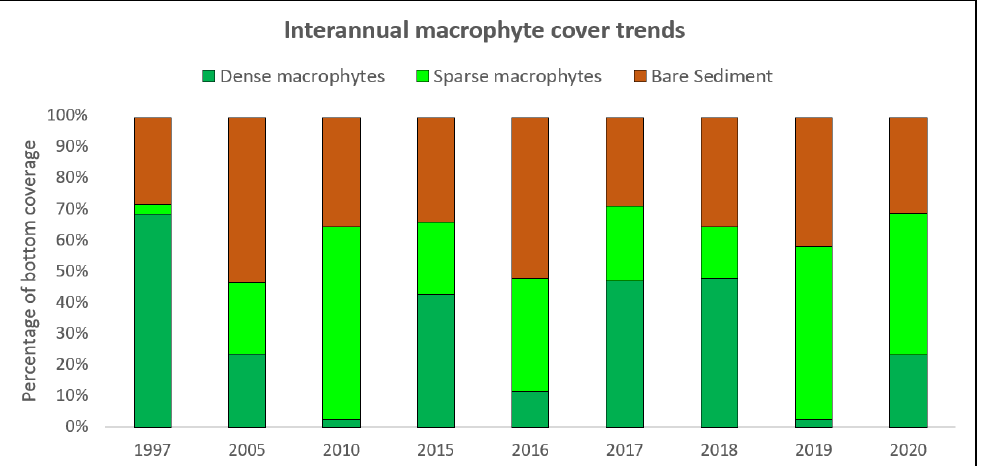
Figure 4. Comparison of macrophyte cover trends (%) from MIVIS maps (16/09/1997, 27/07/2005, 15/07/2010) and summer seasonal maps derived from S2 images (2015 – 2020).